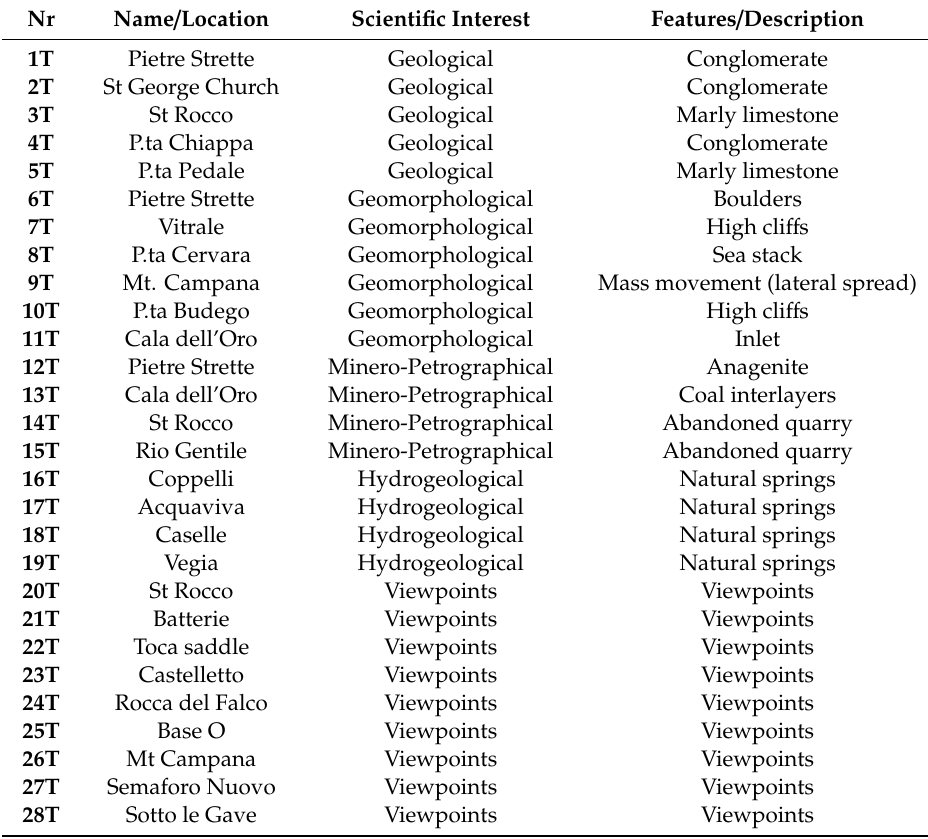
Table 1. Terrestrial